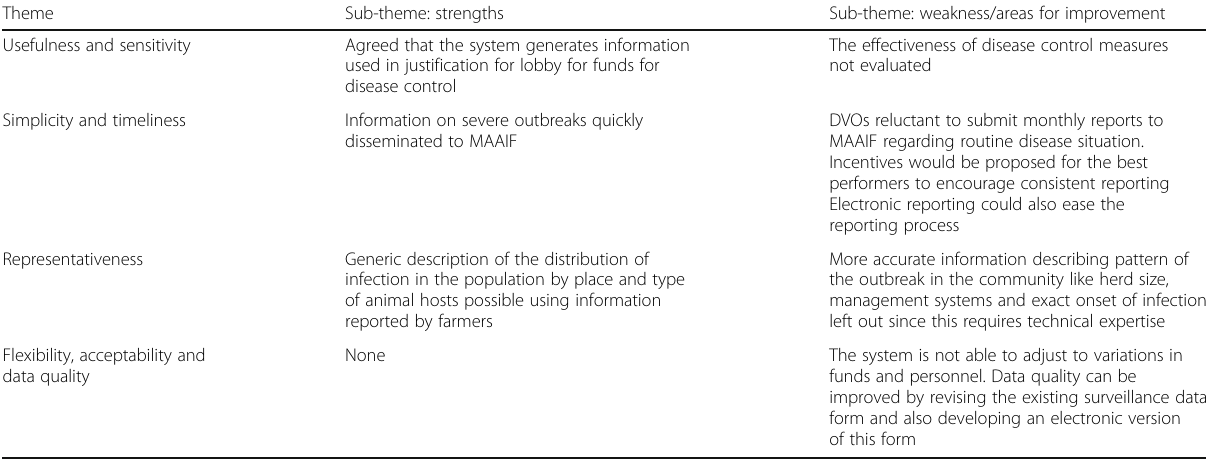
Table 5 A summary of the top-level livestock surveillance system